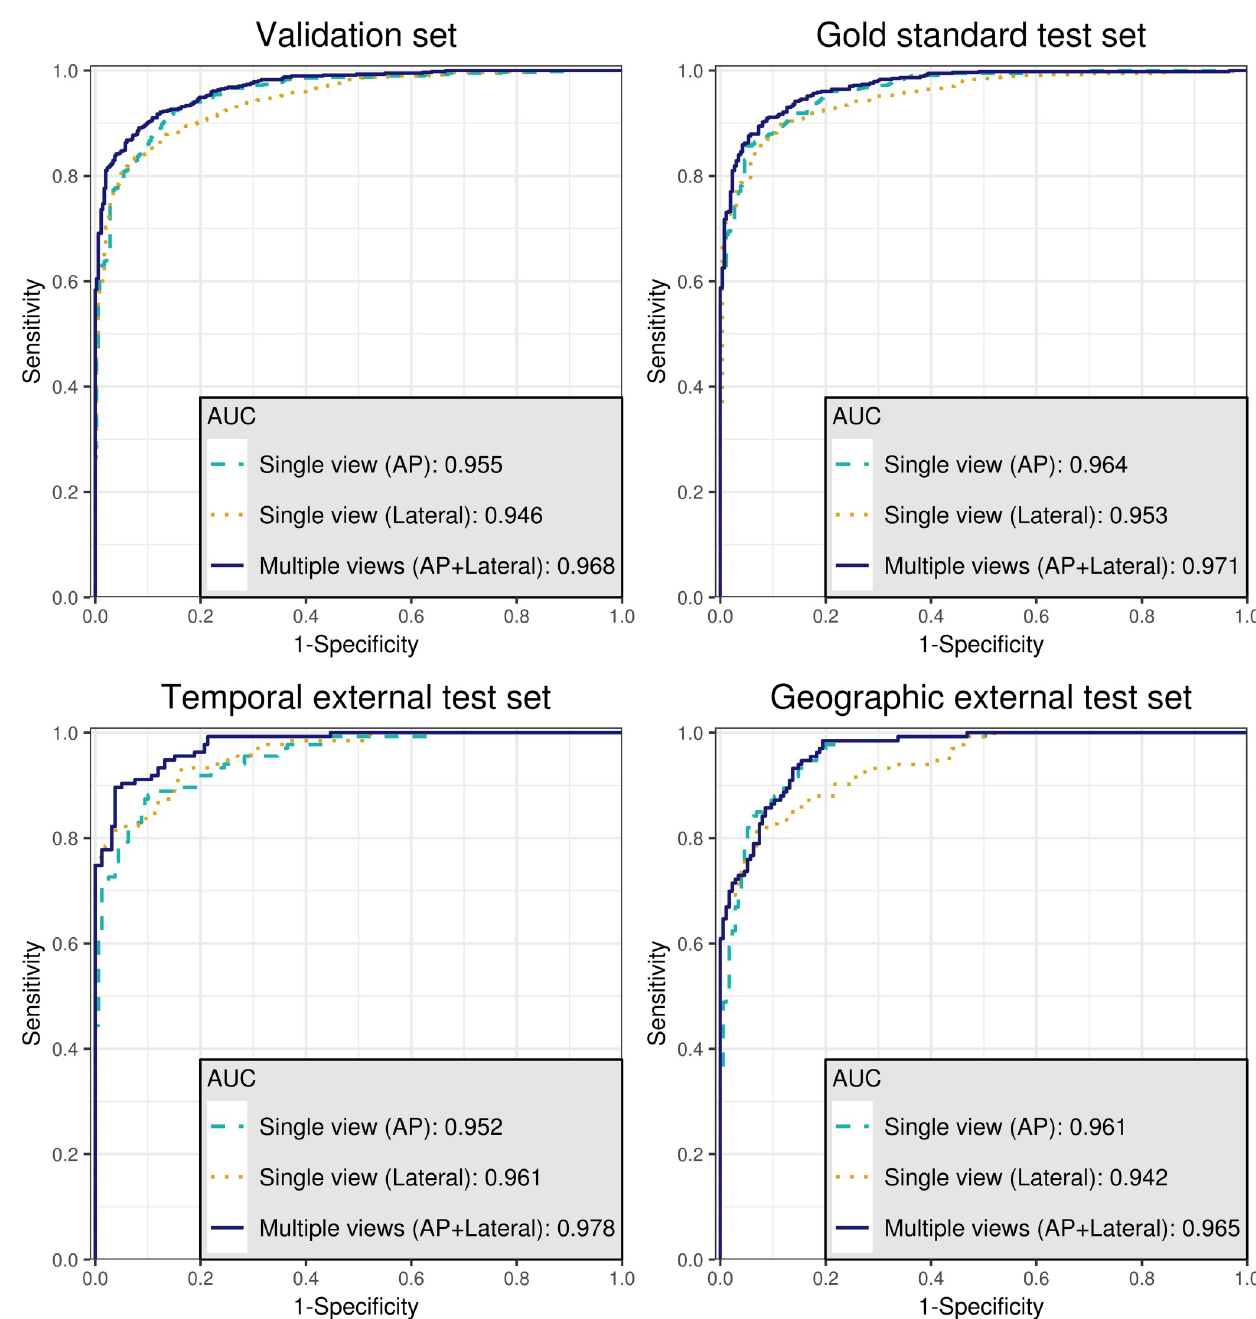
Fig 4. The receiver operating characteristic curves (ROC curves) for validation set and three test sets. The area under the ROC curves (AUCs) using the multiple views show statistically significant higher values than AUCs using a single view (AP view or lateral view only) in the validation set and all test sets. https://doi.org/10.1371/journal.pone.0241796.g004 The AUC, sensitivity, and specificity of the test sets were calculated based on the labels diag- nosed based on both AP view and lateral view. The AUC of the deep learning algorithm for gold standard test set, temporal external test set, and geographic external test set was 0.97 (95% confidence interval, 0.96–0.98), 0.98 (95% confidence interval, 0.97–0.99), and 0.97 (95% con- fidence interval, 0.95–0.98), respectively. The sensitivity and specificity of the deep learning